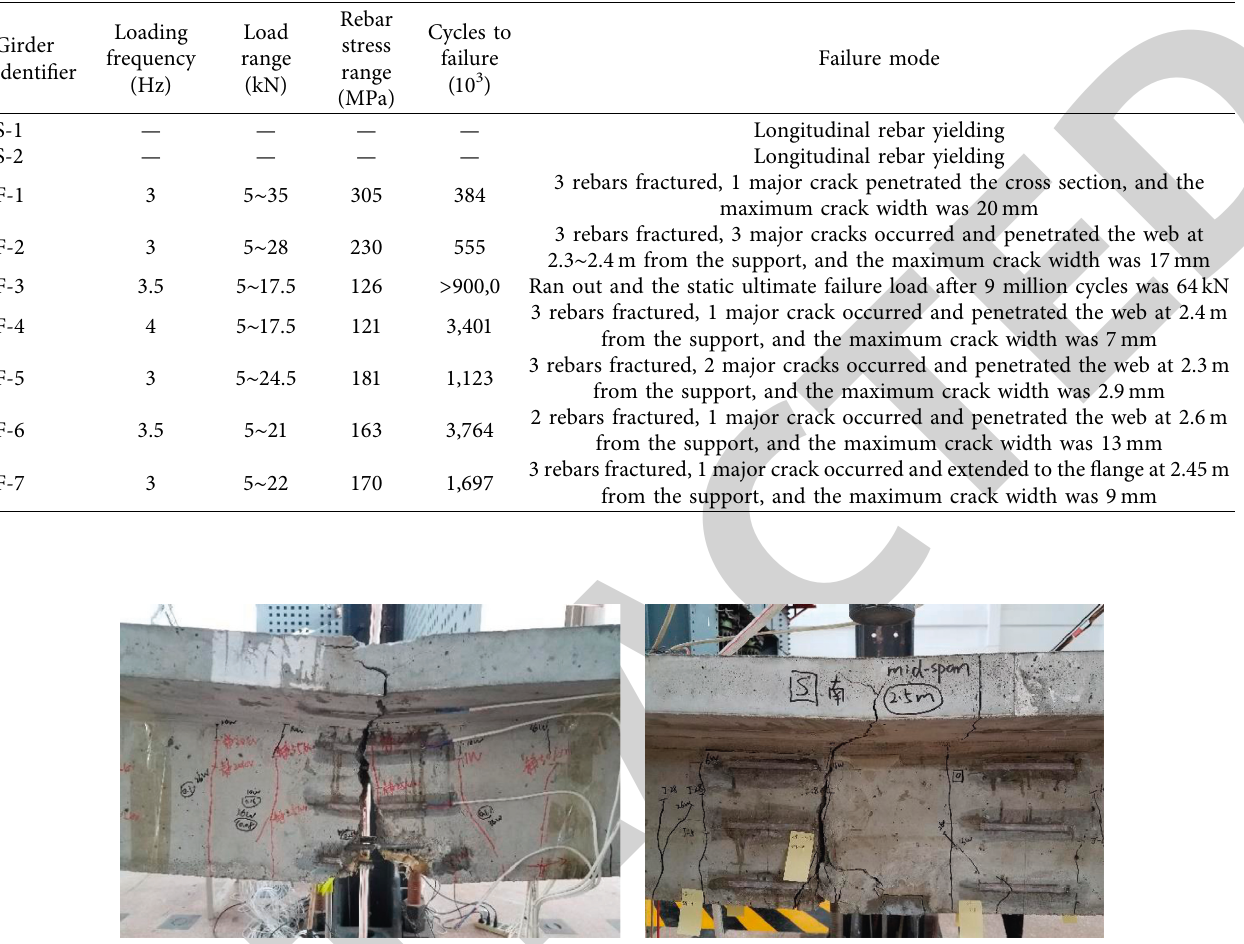
Table 3: Summary of T-girder fatigue failure